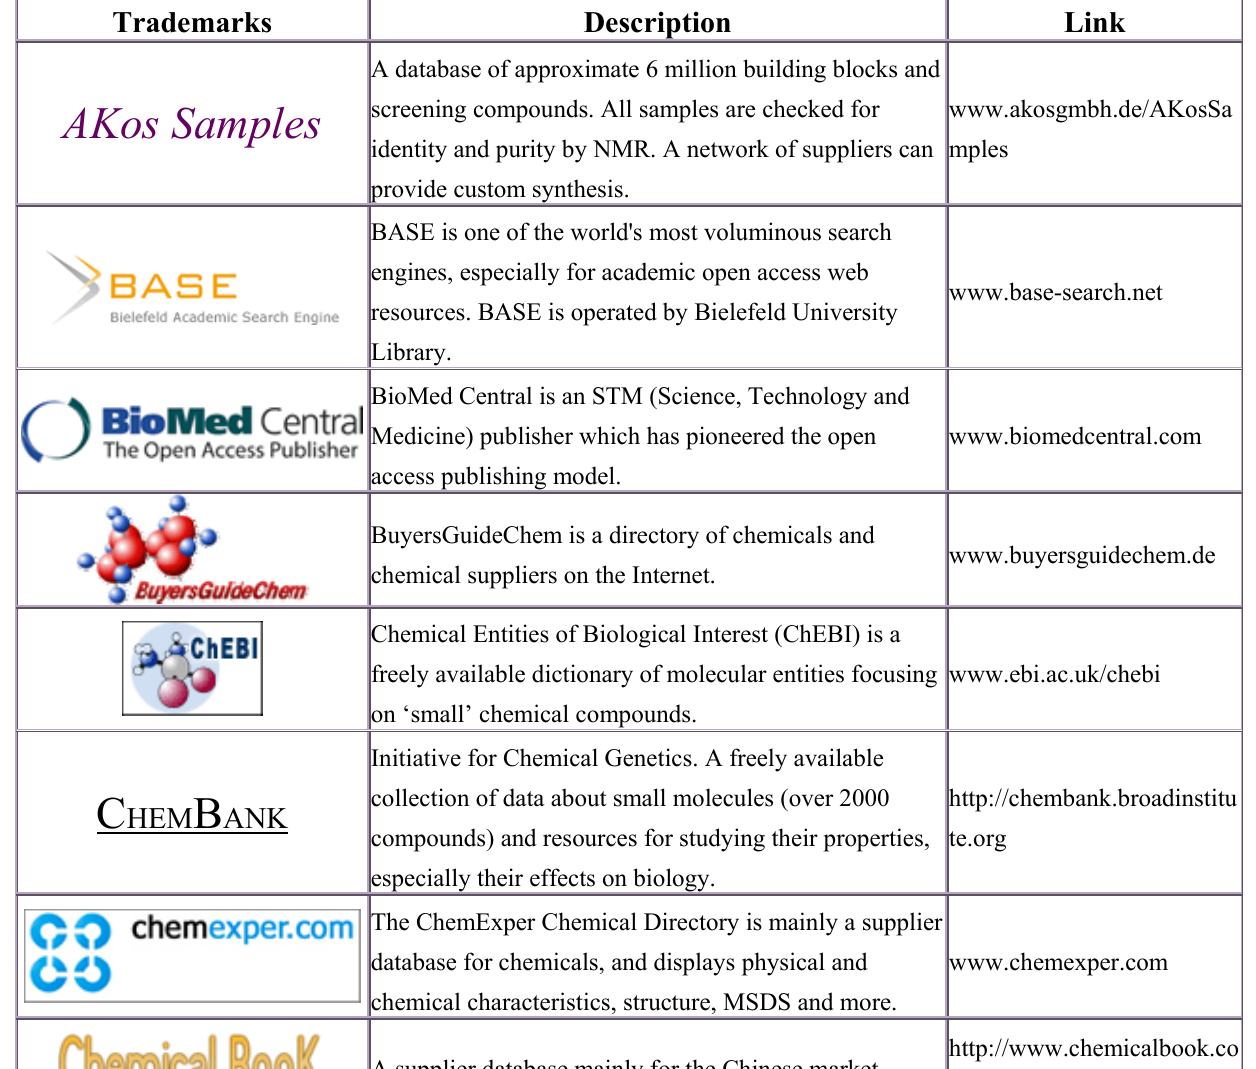
Table 1. A list of the sources searchable in Global Search. An up-to-date list of data sources can be found at: http://www.akosgmbh.de/globalsearch/databases_in_gs.htm.